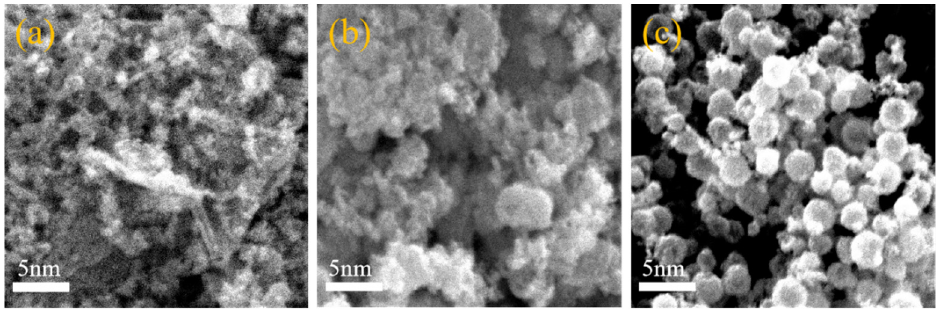
Figure 2. The SEM images of pure In 2 O 3 ( a ), 2 mol%La-In 2 O 3 ( b ) and 2 mol%Au/2 mol%La-In 2 O 3 ( c